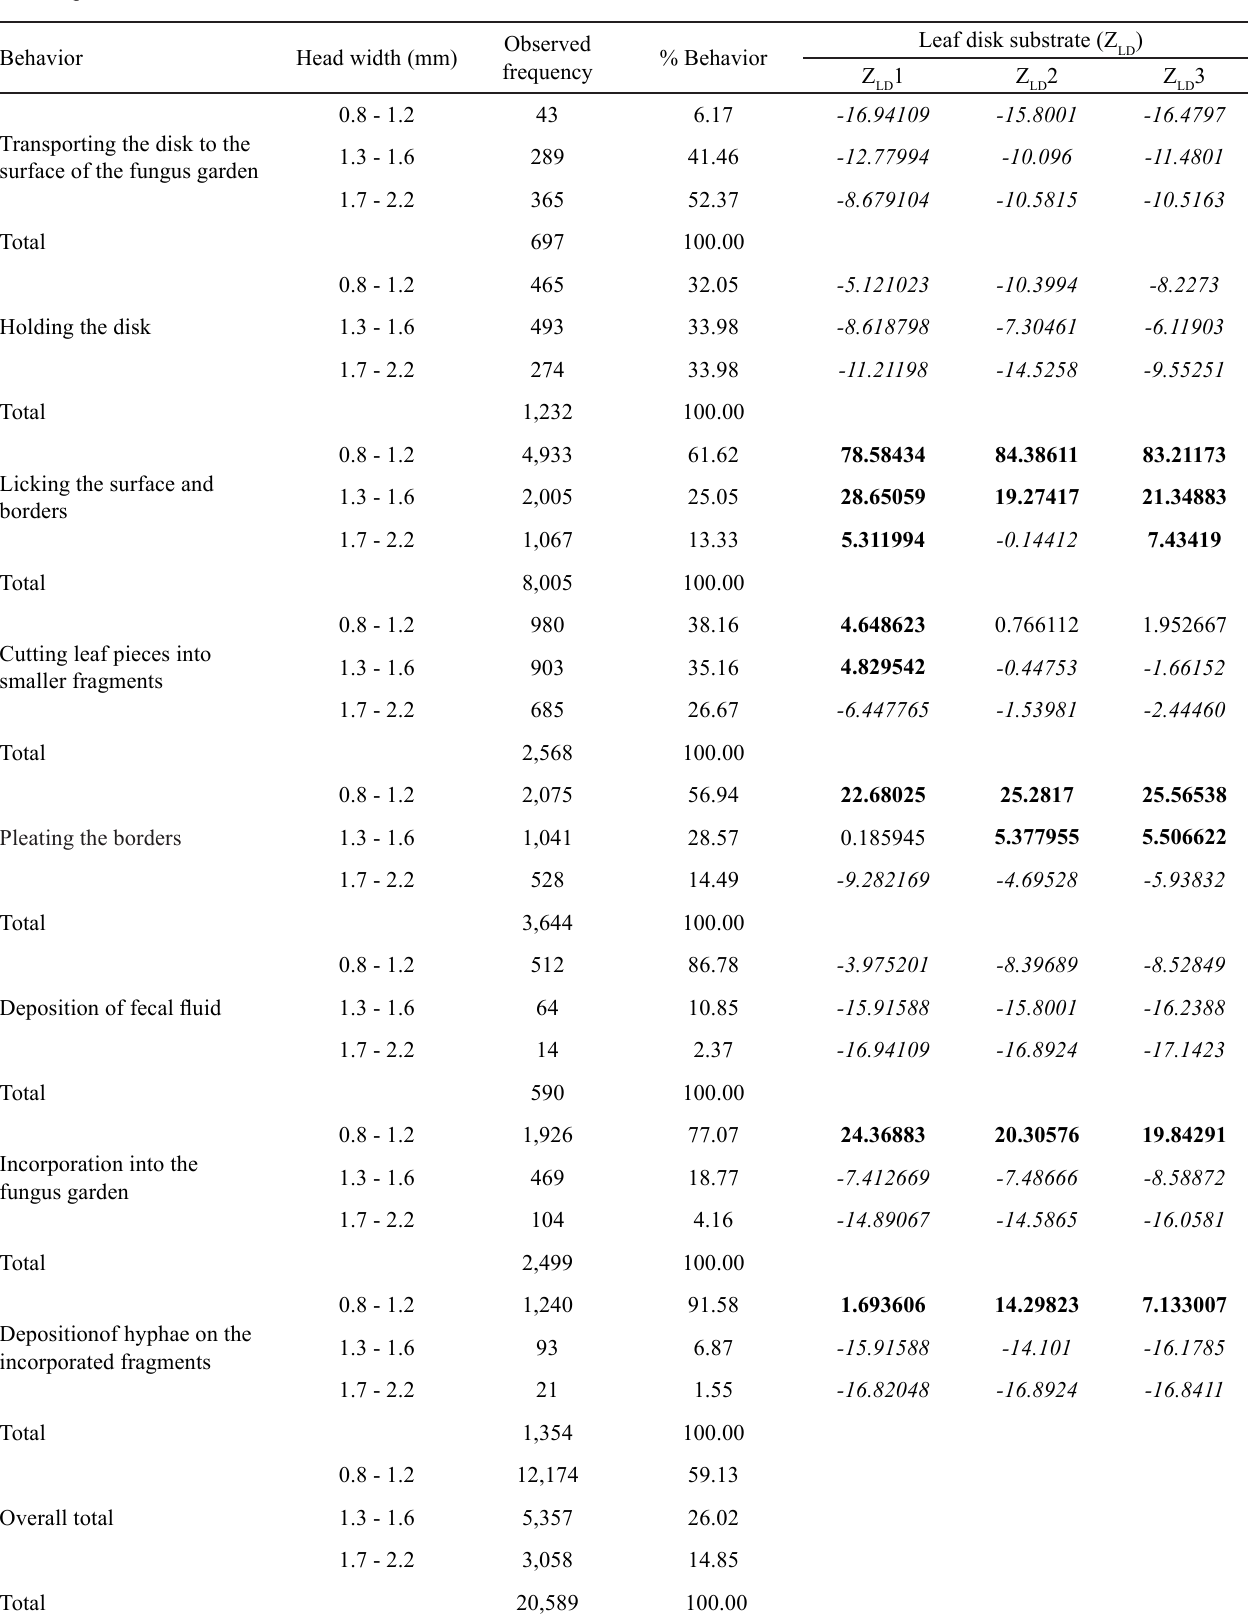
Table 1 .Standardized residuals in contingency table analysis of the behaviors executed by Atta sexdens rubropilosa during the preparation and incorporation of leaf disksas